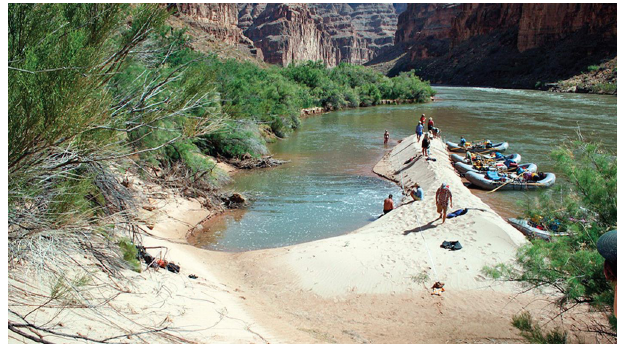
Fig. 3 . A river-left sandbar in Grand Canyon National Park, created as a result of the March 2008 high flow experiment at Glen Canyon Dam. To the left of the sandbar is a newly created backwater. Backwaters are areas of low-velocity flow that may be used by both juvenile endangered humpback chub and non- native fish such as trout. Sandbars also provide camping beaches for hikers and whitewater rafters. (Credit: J. E. Hazel, Jr.)